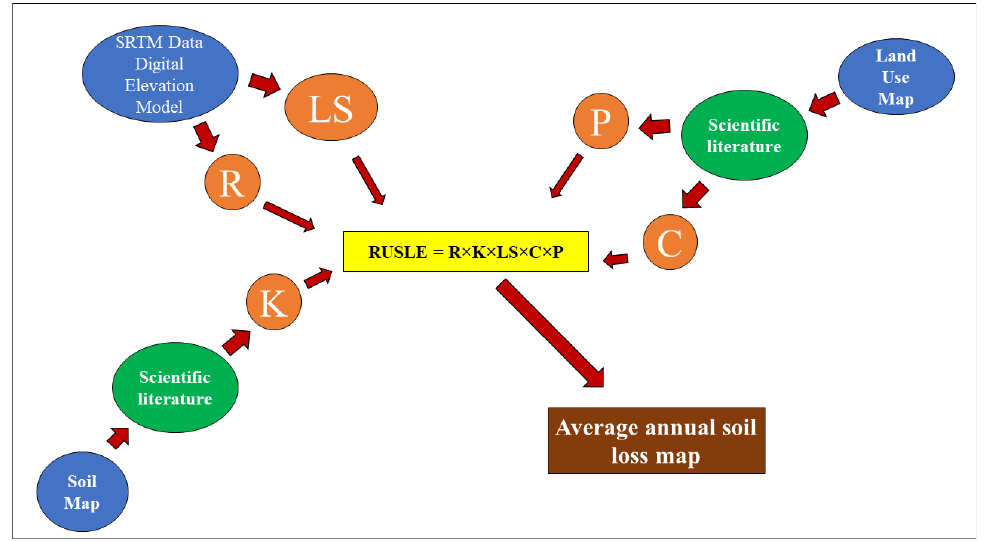
Figure 2. Flow chart of the methods used to estimate soil erosion.